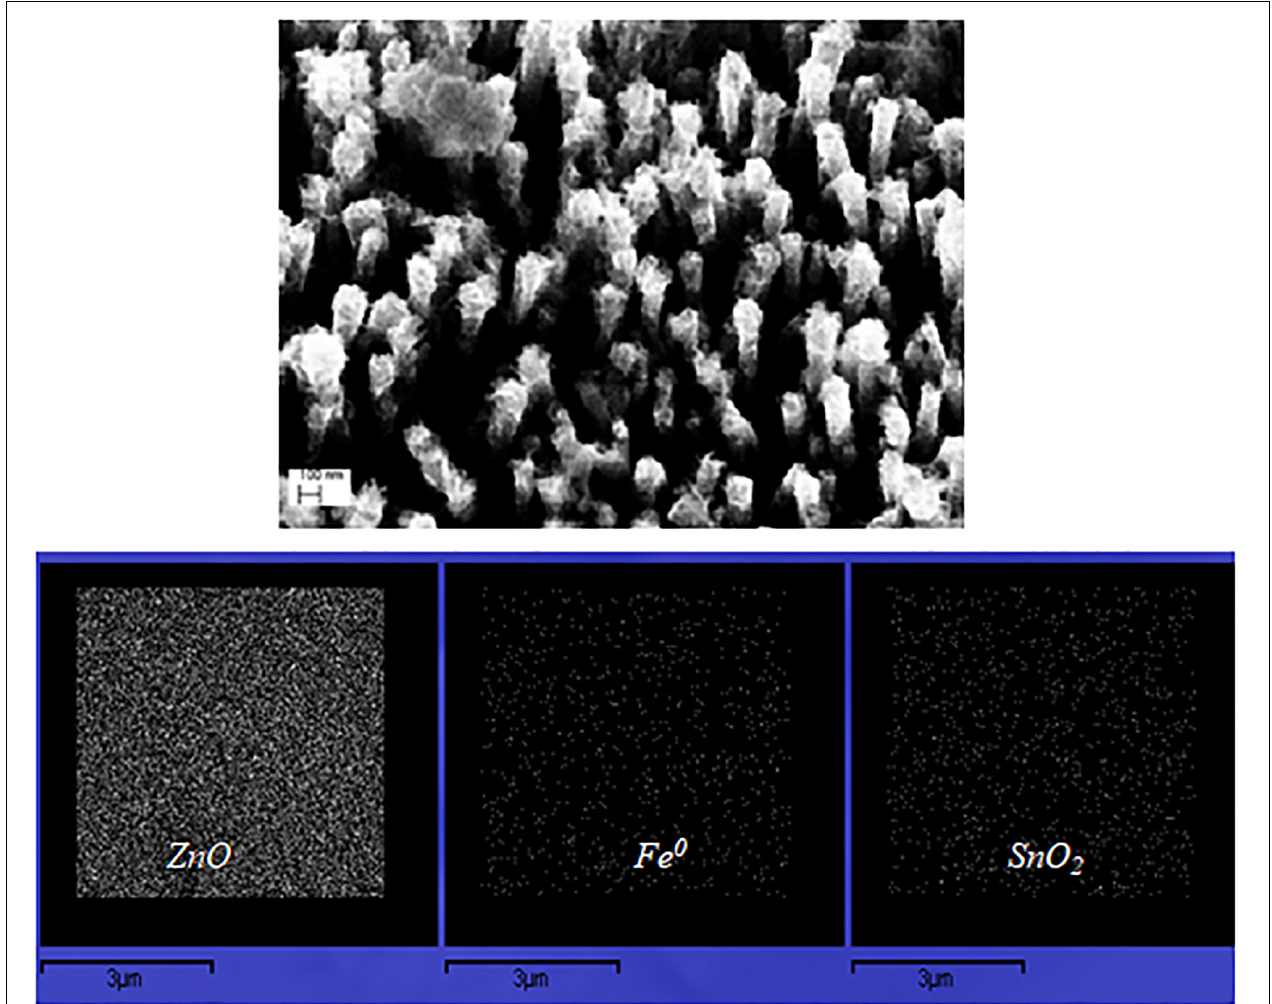
FIGURE 2 | SEM image of ZnO NRs coated with SnO2 layer and decorated with Fe0 NPs; and EDX image of the distribution of ZnO, SnO2, and Fe0